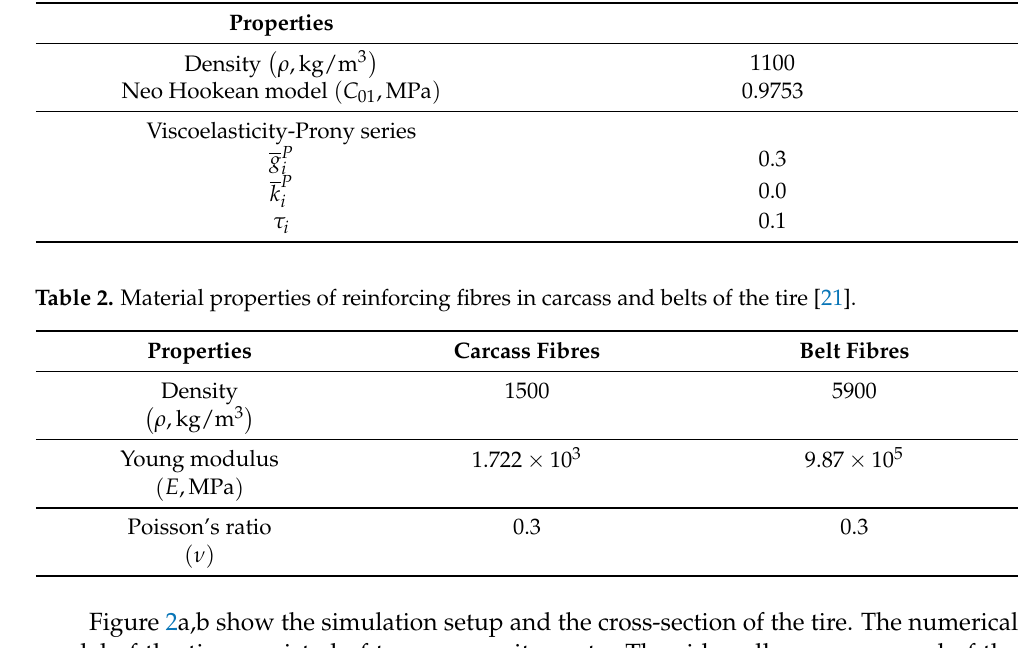
Table 1. Material properties of tread and sidewall rubber of the tire [21].